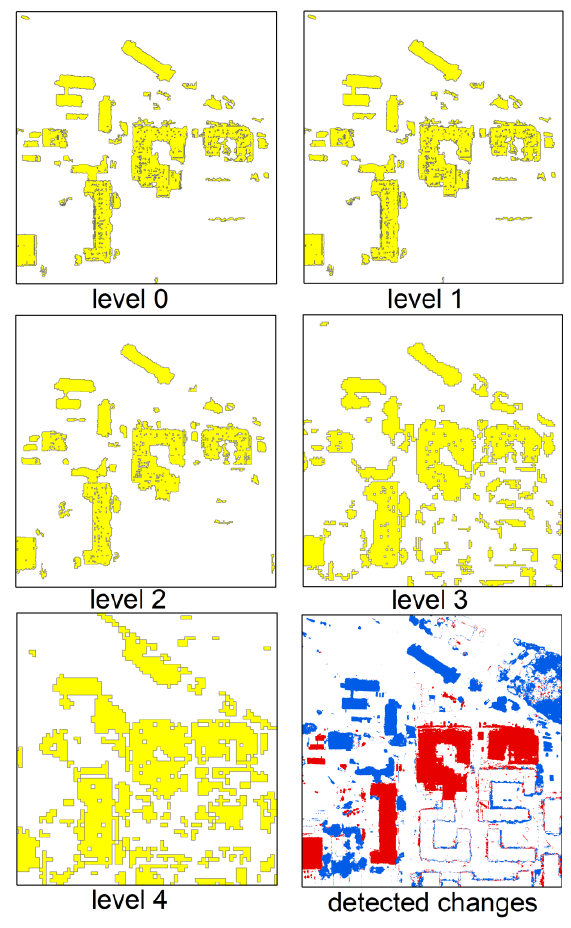
Figure7. Comparison of reclassified differences (changes) before and after vegetation